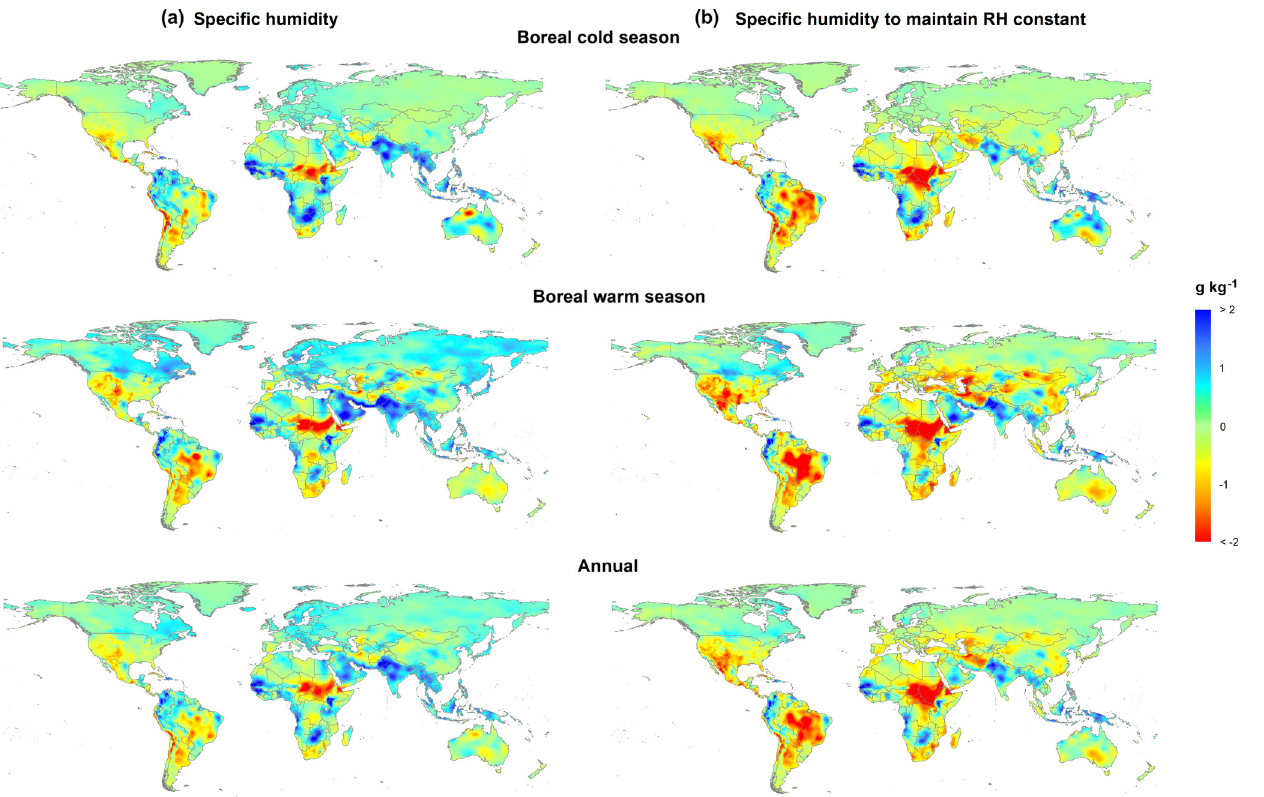
Figure 3. Spatial distribution of the seasonal and annual magnitudes of change in specific humidity (gkg 1 ) (a) and the deficit/surplus of specific humidity to maintain constant RH at the levels of 1979 (b) according to land air temperature evolution (from the CRU TS v.3.23 dataset) for